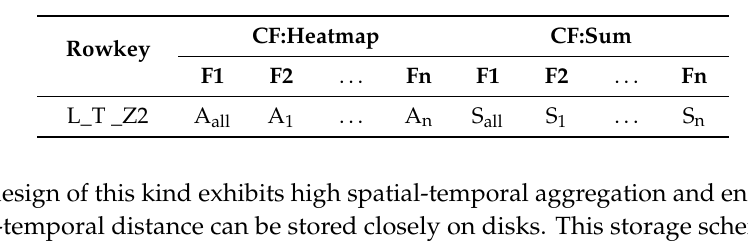
Table 1. The HBase storage schema for